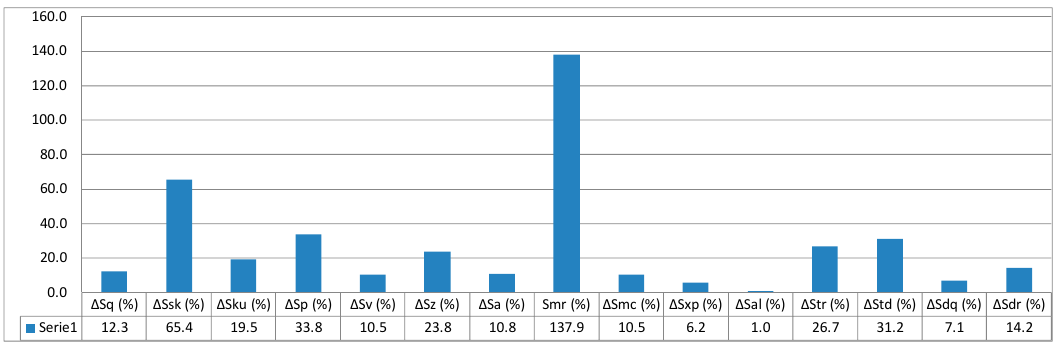
Figure 10. Relative values of surface parameters for printing orientation 0°.